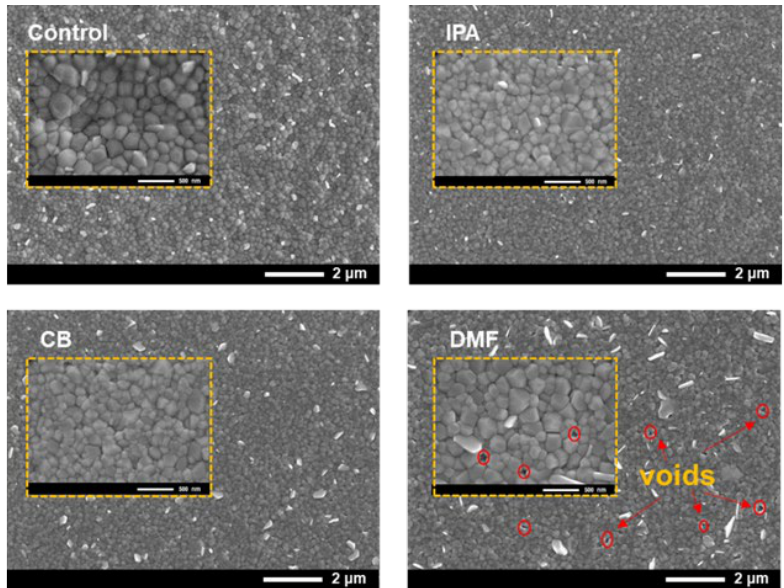
Figure 3. Planar SEM images of perovskites annealed under different atmospheres, with a scale bar of 2 μm. Inset: zoom-in picture, scale bar: 500 nm. All perovskite films were prepared on PTAA-coated ITO glass.